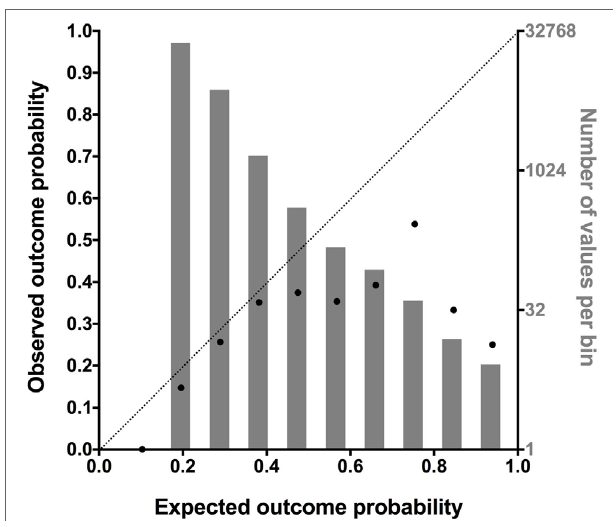
FigUre 7 | A combination plot comparing the predicted case fatality probability divided into deciles against the observed case fatality probability (black dots, abscissa, and left ordinate). This analysis was conducted to further assess the cause of the poor model fit. A value of 0.0 indicates 0% fatality, a value of 0.5 indicates 50% fatality, and a value of 1.0 indicates 100% fatality. A line of identity is also plotted to aid interpretation. As can be seen from comparing the line of identity to the black dots, as the mortality rate predicted by the model increases above 0.5, the correlation between predicted and observed mortality decreases. This suggests the model overestimated the likelihood of fatality as the probability increases. As indicated by the number of profiles in each of the deciles (gray bars, right ordinate, log-2 scale), there were many cases with low predicted mortality but few cases with a high predicted